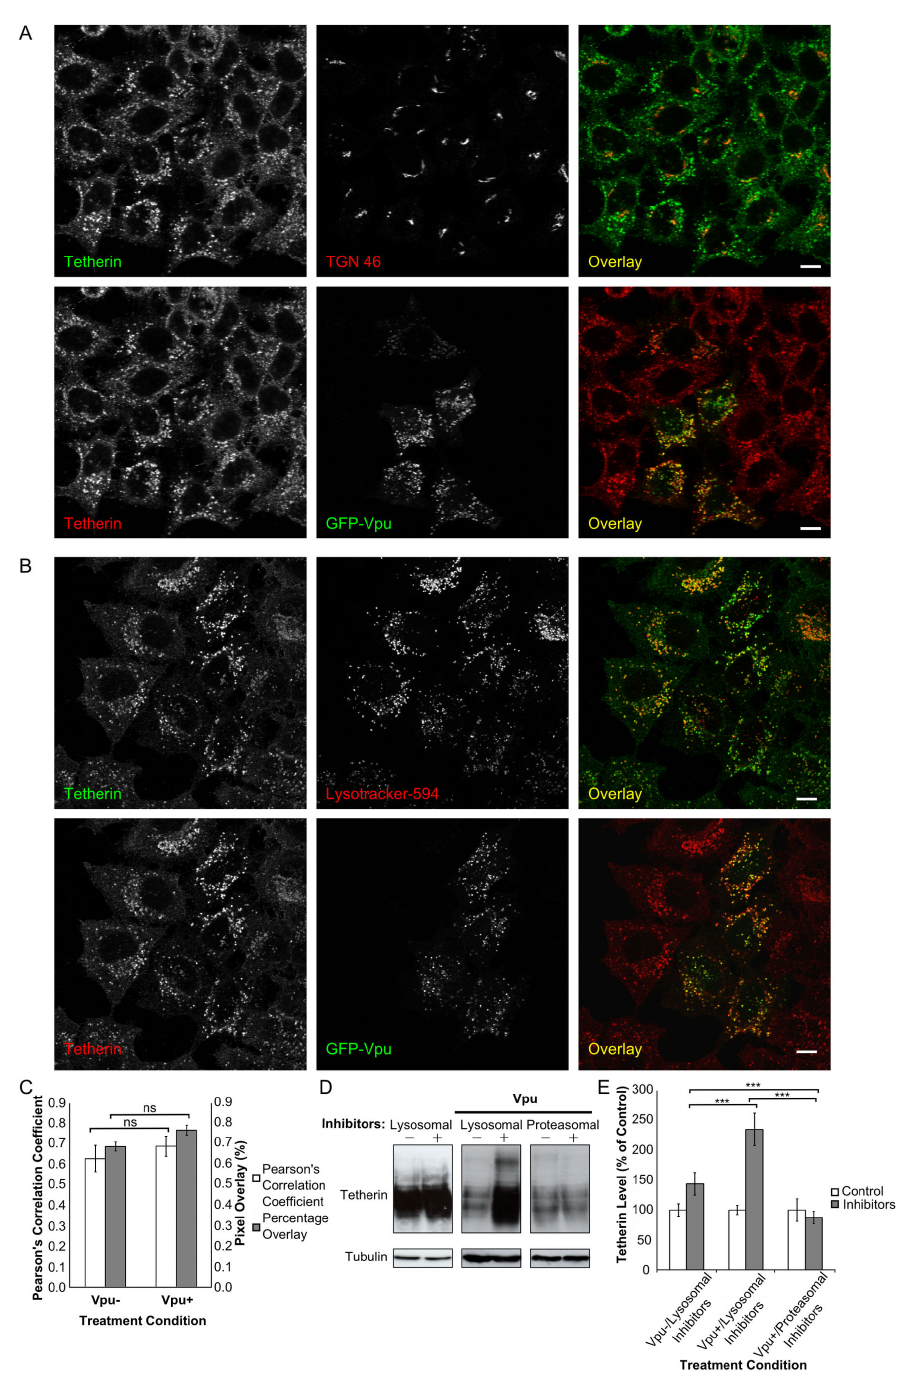
Figure 6. Lysosomal degradation of tetherin. A .and B . Triple label fluorescence analysis (antibody detection of Vpu, tetherin and TGN46, and LysoTracker detection of lysosomes) of HeLa cells that had been incubated in the presence of lysosomal inhibitors for 24 hours prior to processing for immunofluorescence analysis. Cells expressing Vpu demonstrated significant accumulation of tetherin in lysosomes ( B ), but not in the TGN ( A ). Bar = 10µ. C . Quantification of co-localisation between LysoTracker-594 and tetherin, using both Pearson’s correlation coefficient and percentage pixel overlay. D . Immunoblot analysis, using an antibody to endogenous tetherin, of lysates from control HeLa cells, or HeLa cells expressing Vpu-GFP (Vpu) that had been incubated in the presence of lysosomal (24 hours) or proteosomal (12 hours) inhibitors (as indicated). The lower panels show immunoblots for tubulin as loading controls. E . Graphical representation of quantification of the data presented in D , P=0.0002, n = 3. doi: 10.1371/journal.pone.0075680.g006 PLOS ONE |